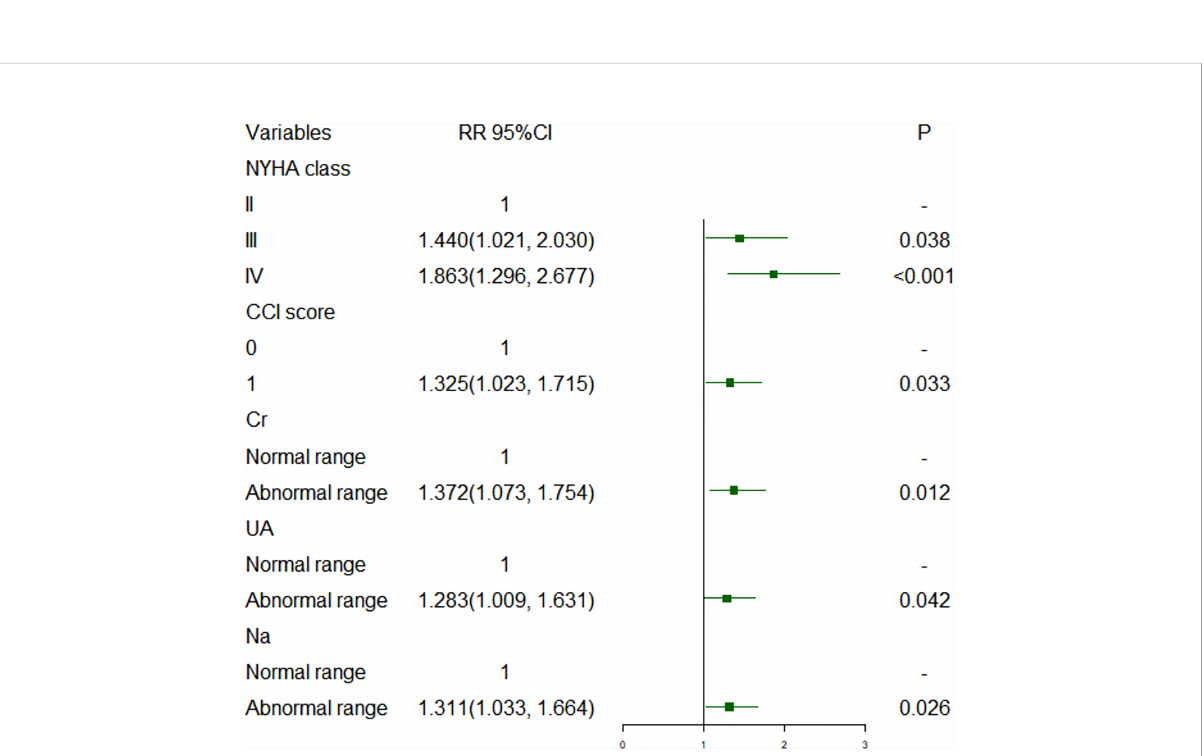
FIGURE 4 Risk factors for readmission within 3 months of heart failure patients: multivariate logistic